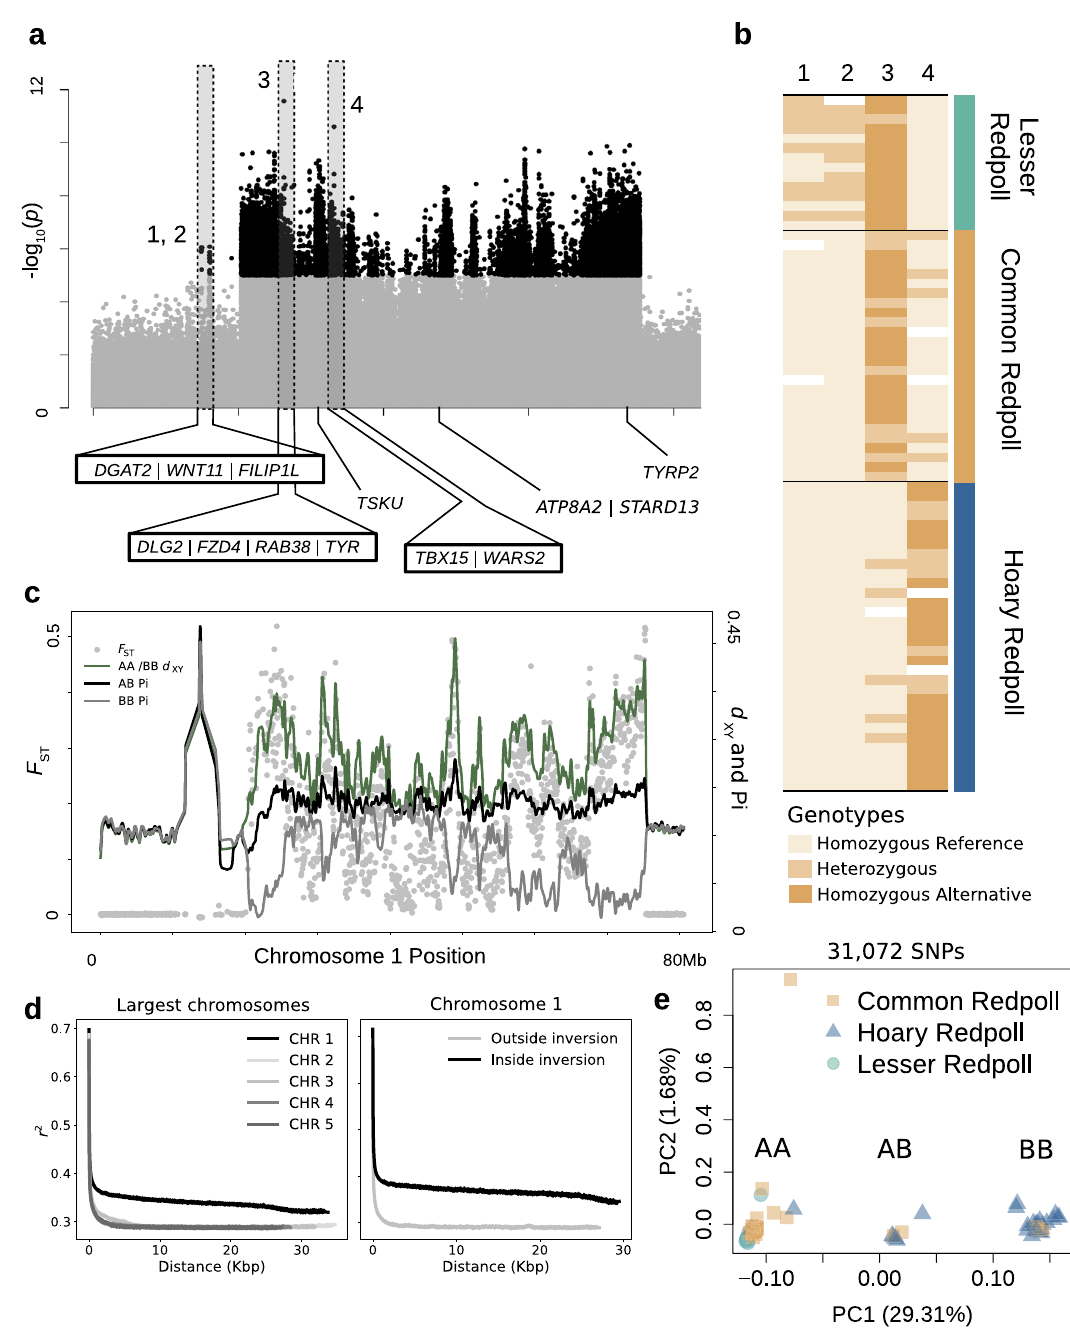
Fig. 2 Chromosome 1 supergene. a Chromosome 1 SNPs signi fi cantly associated with phenotype (black dots) using mixed model analysis in GEMMA with an alpha of 1 × 10 − 5 to correct for multiple comparisons. Numbers indicate the two most signi fi cant SNP associations outside (1,2) and inside (3,4) the inversion region and correspond to genotypes in ( b ) for those speci fi c SNPs. Lightest yellow cells indicate individuals homozygous for the reference allele, darkest indicate homozygous for the alternative allele, intermediate indicate heterozygotes, and white are missing data. c Pi (black and gray lines for AA and AB individuals, respectively) and d XY (green line) in 50-kb windows for the fi rst 80 Mb of chromosome 1. d LD calculated as r 2 comparing chromosome 1 (black line) to 4 of the other largest chromosomes (shades of gray) and LD within the supergene (black) to the rest of chromosome 1 (gray). e PCA of chromosome 1 with a 40% minor allele frequency cutoff showing three main clusters along PC1. Taxa colors correspond to Fig. 1. All sequences were aligned to a brown-capped rosy- fi nch ( Leucosticte australis ) reference genome. Source data are provided as Source data fi